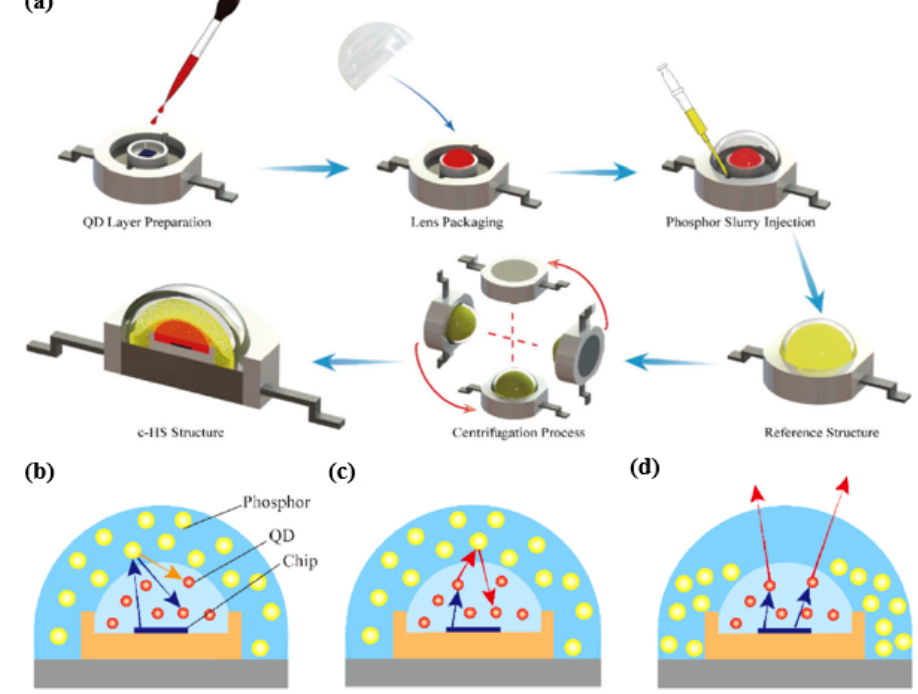
Figure 8. ( a ) Diagram of the fabrication process of WLEDs c-HS structure. Diagram of the light-extraction mechanism in Q–P hybrid WLEDs. ( b ) Backscattered blue light and backward-emission yellow light in the top region of reference structure; ( c ) backscattered red light in the top region of reference structure; ( d ) extraction red light with less backscattering in the top region of the c-HS structure [65]. Figure reproduced with permission from Optical Society of America.